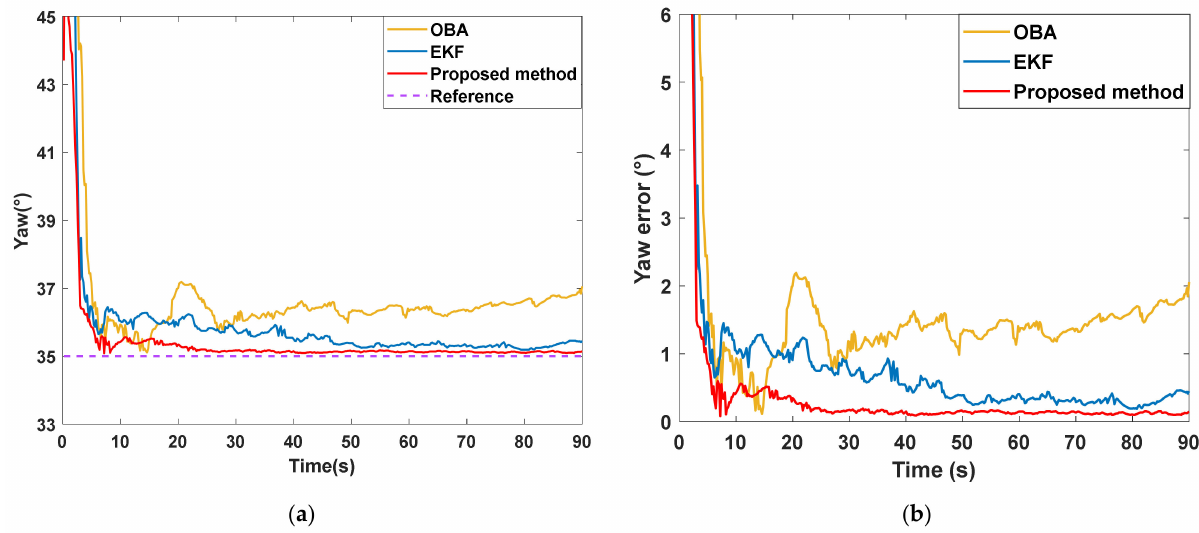
Figure 10. Simulation results of yaw angle alignment with different alignment methods. ( a ) Yaw angle alignment results of different alignment methods; ( b ) absolute value of yaw alignment error of different alignment